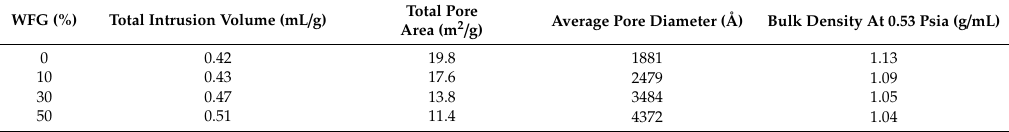
Table 4. Average values of mercury intrusion porosimetry (MIP) parameters determined for the produced composites.